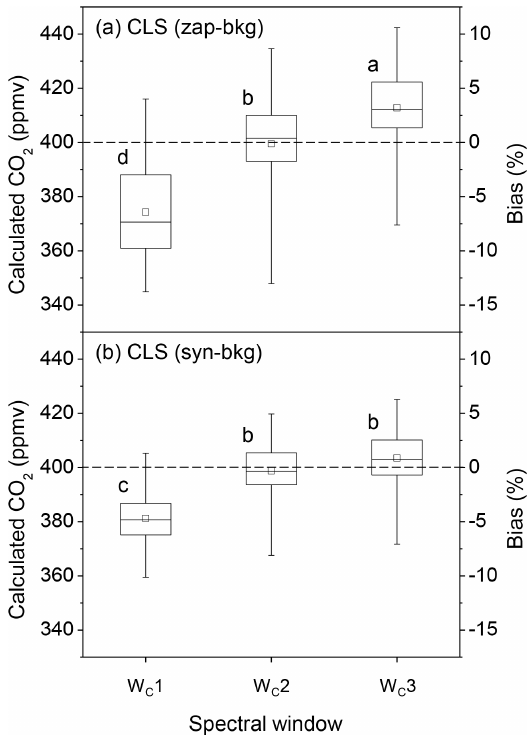
Figure 6. The box plots of the calculated CO 2 concentrations and the corresponding biases from a series of OP-FTIR spectra ( n = 93) that contain 400 ± 3 . 0ppmv CO 2 with varying humid- ity and air temperature using different SB background-processing methods (zap-bkg and syn-bkg) and three spectral windows ( W C 1– 3) in the CLS model: (a) zap-bkg and (b) syn-bkg. The plot dis- plays the mean ( (cid:3) ), median (–), interquartile ranges (box), and ex- treme values (whiskers). Different letters indicate significant differ- ences ( p <0.05) among the means calculated by different quantita- tive methods by the least significant difference